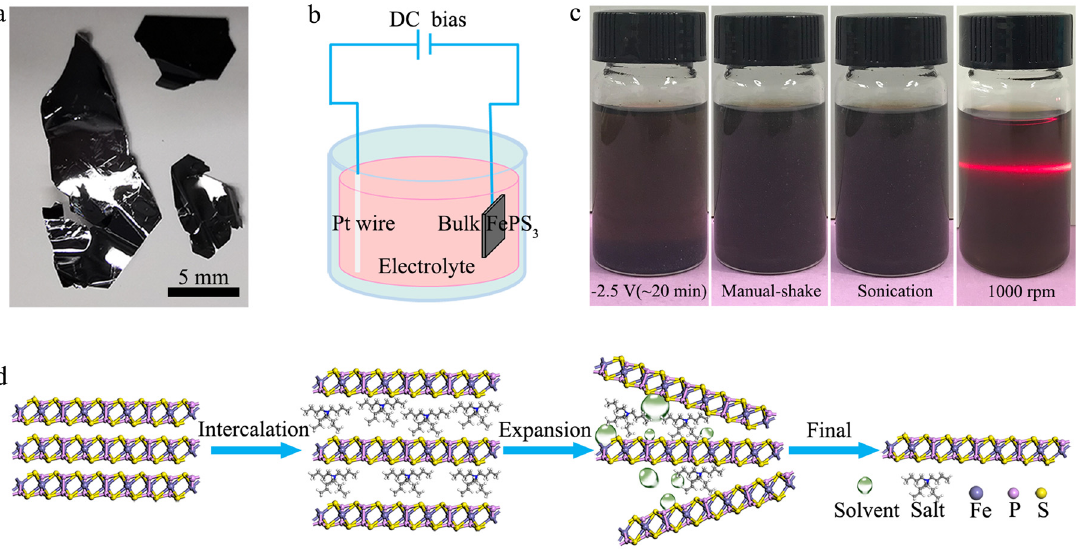
Figure 1: The electrochemical cathodic exfoliation process. (a) Pictures of bulk iron phosphorus trichalcogenide (FePS 3 ) single crystals. (b) Diagrams of the equipment used for electrochemical exfoliation. (c)Fromlefttoright:picturesoftheexpandedFePS 3 ,a dispersedFePS 3 solutionaftermanualshaking,a dispersedFePS 3